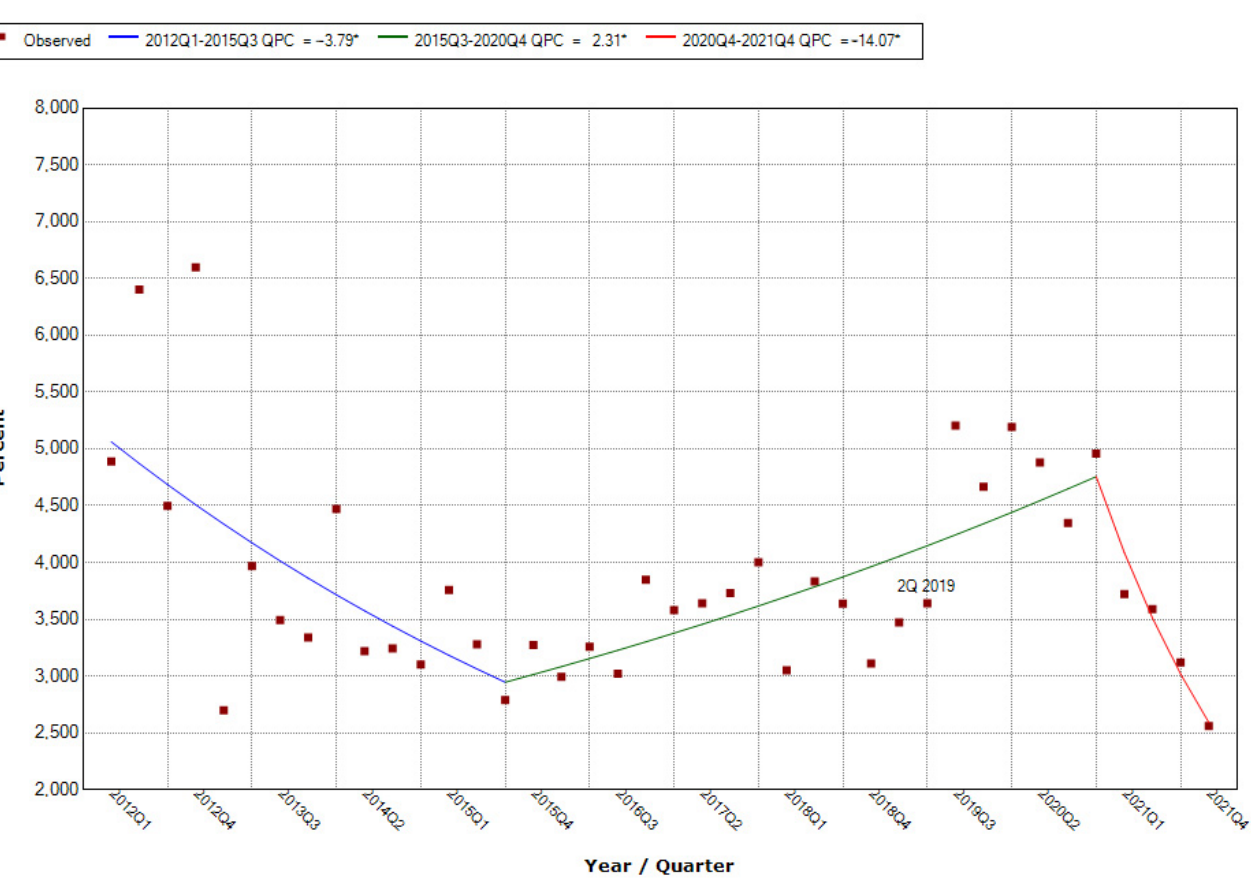
Figure A31. Percentage of products containing manganese in individual quarters in the period from 2012 to 28 November 2021. Joinpoints mark trend turning points. The date above the observation indicates the moment of publication of the scientific opinion/resolution.